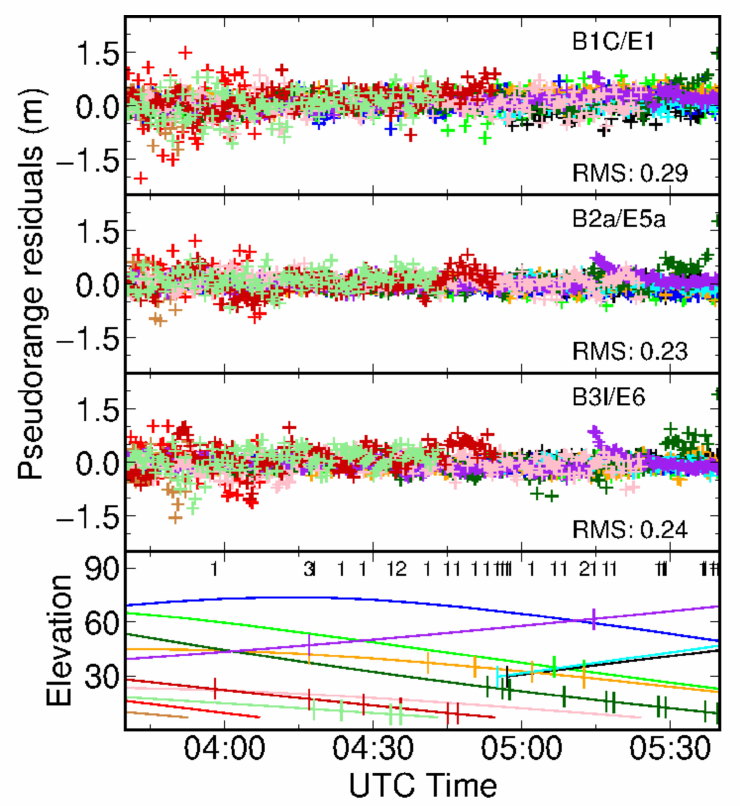
Figure 7. Galileo/BeiDou-3 satellites pseudorange residuals of Group A PPP-AR and the elevation angles. Cycle slips are marked with short vertical lines on each elevation curve. The number of satellites with cycle slips at each epoch is marked in the bottom